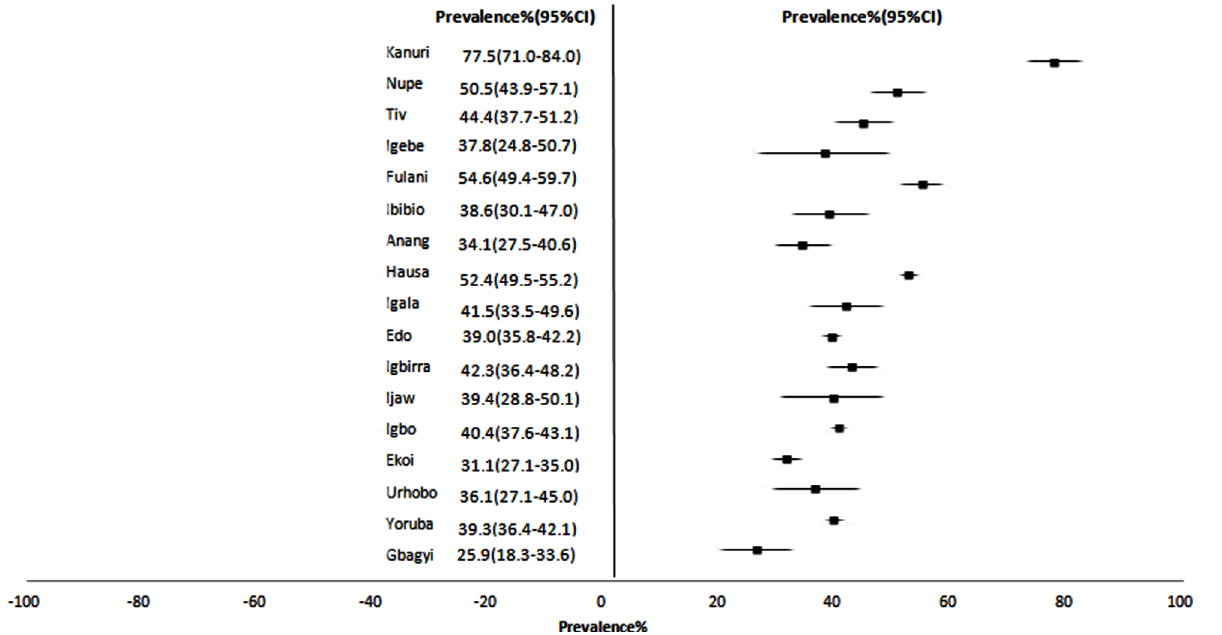
Fig 5. Forest plot showing hypertension prevalence and 95% CI across 17 ethnic groups in the Murthy, G et al 2013 study[73].